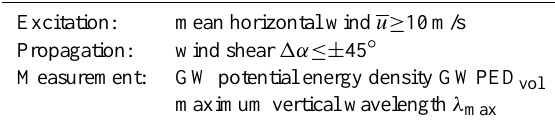
Table 1. Key parameters for analysis of gravity wave